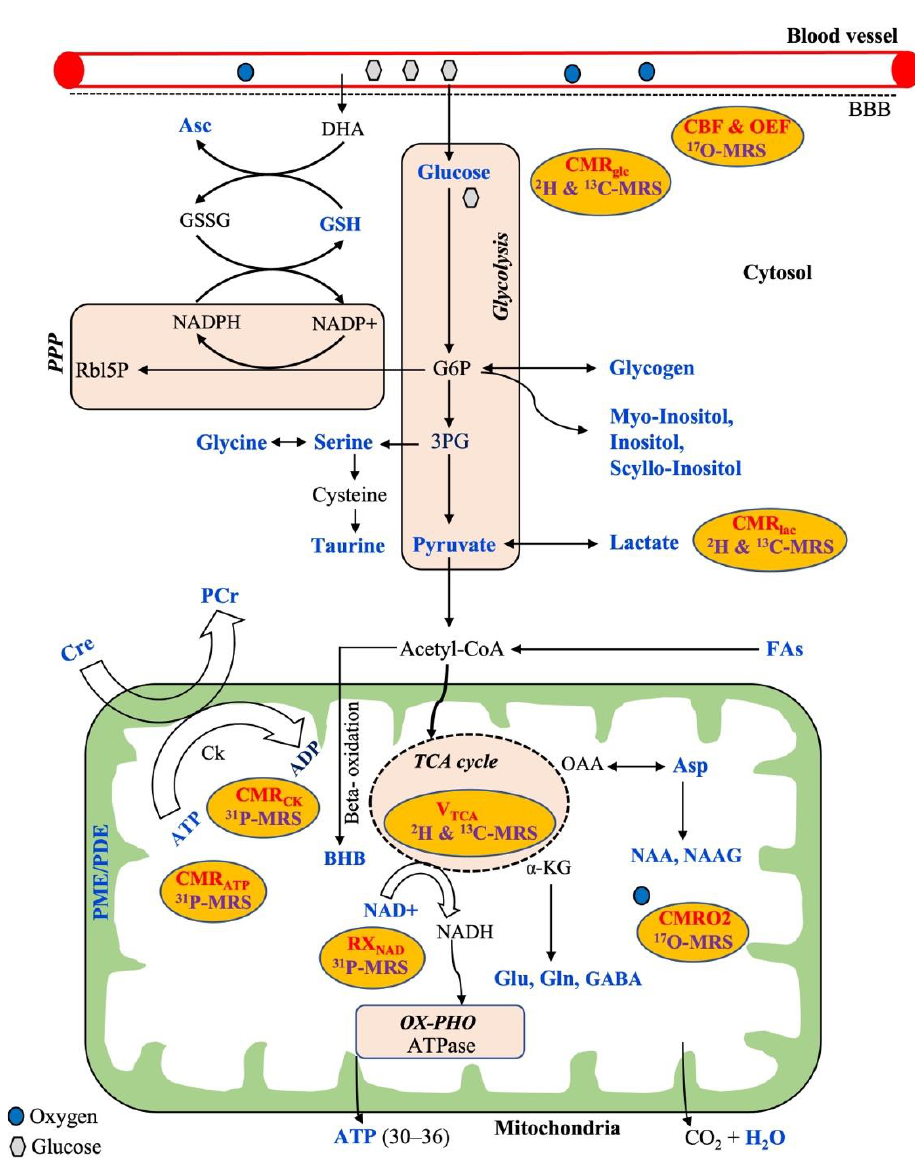
Figure 1. Overview of a neural cell showing common metabolic pathways (brown) for energy pro- duction with relevant metabolic substrates, metabolic intermediaries, and corresponding measurable metabolic parameters (in red) which are related to the respective multinuclear MRS techniques (purple). All the metabolites highlighted in a blue color are possible to detect by MRS techniques.